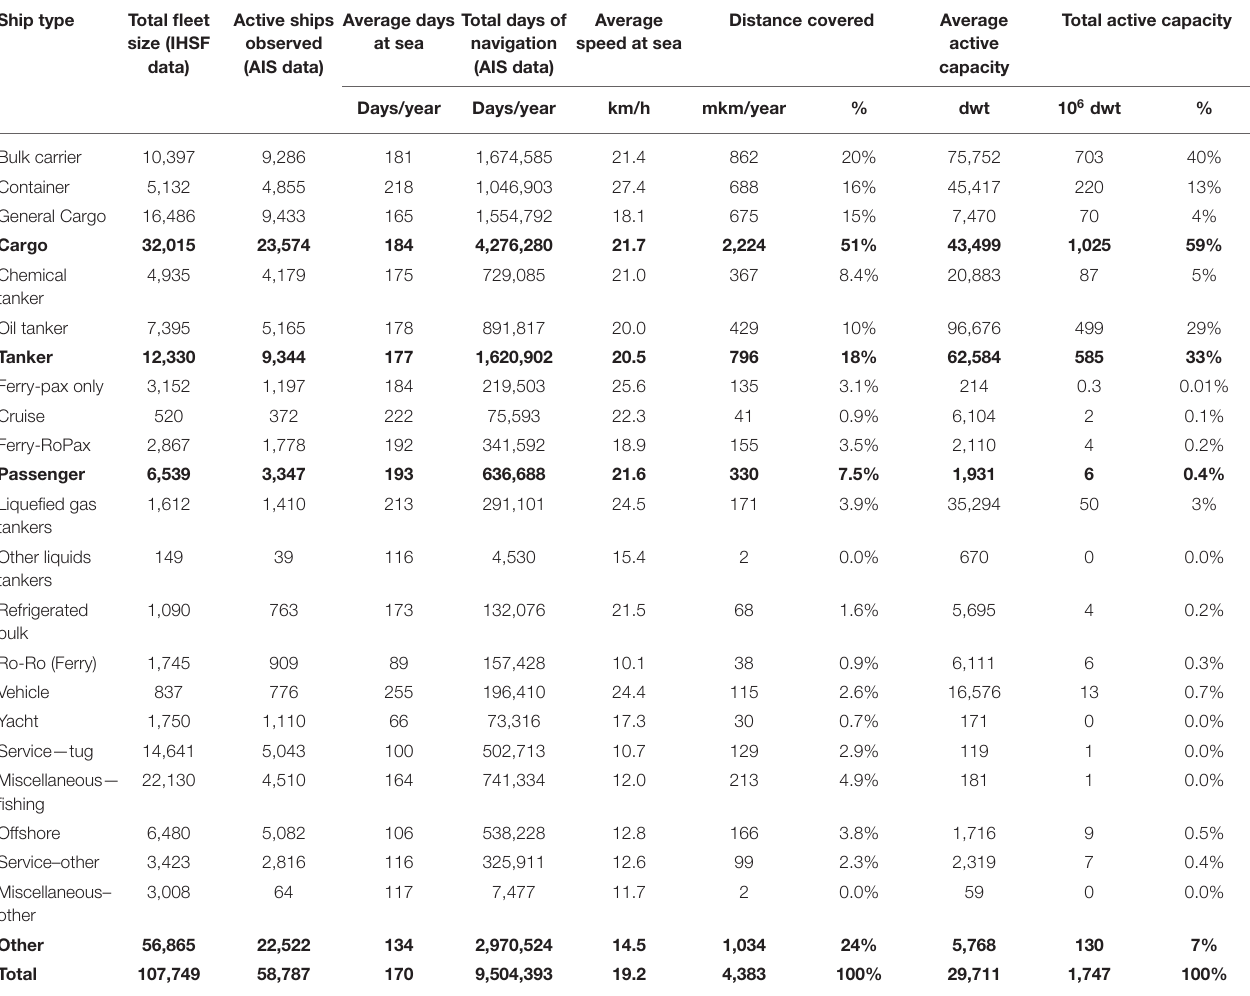
TABLE 1 | Main characteristics of the existing maritime fleet (Data source: IMO–International Maritime Organization, 2014). Ship